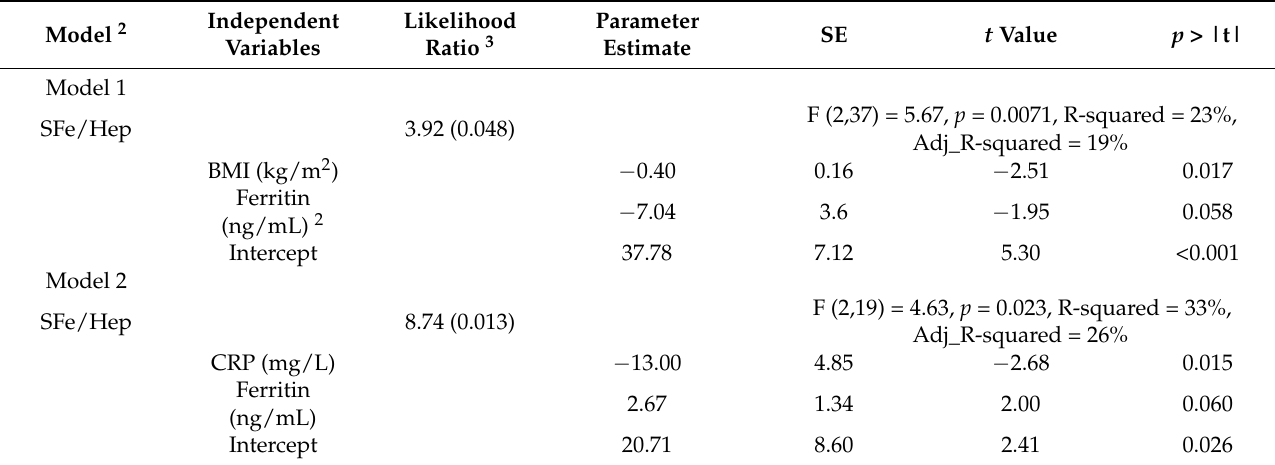
Table 4. Predictors of SFe/Hep in reproductive age women (Model 1, normal-weight and obese women combined; Model 2, obese women only) 1